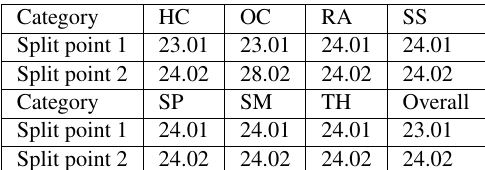
Table 3. Period segmentation of 02 Jan to 02 Mar, 2020